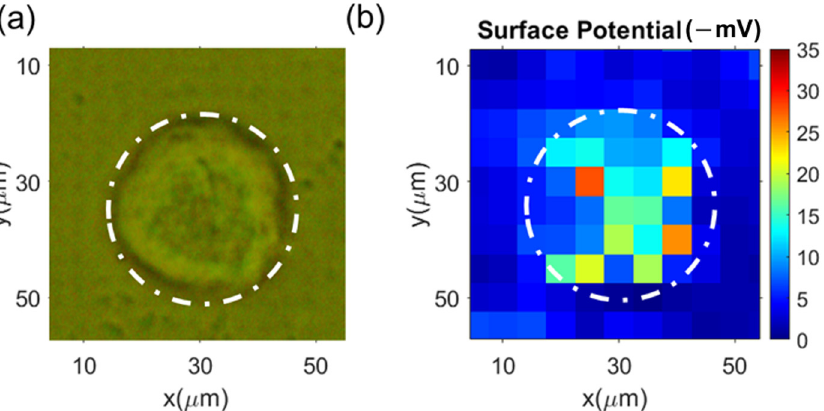
Figure 6. Typical measurement results of the surface charge mapping of HDFs: ( a ) optical images (top illumination) of the cells on the microelectrode array; ( b ) the corresponding surface charge mapping from the reflected images (measured from the back side of the microelectrode chip).